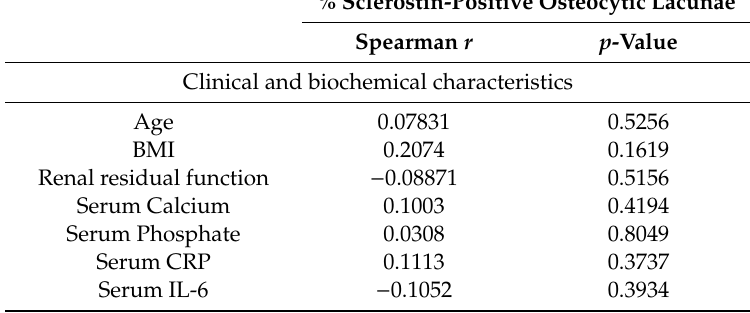
Table 8. Spearman correlation matrix of skeletal sclerostin expression vs. demographic and biochemical characteristics. Note: CRP = C-reactive protein.